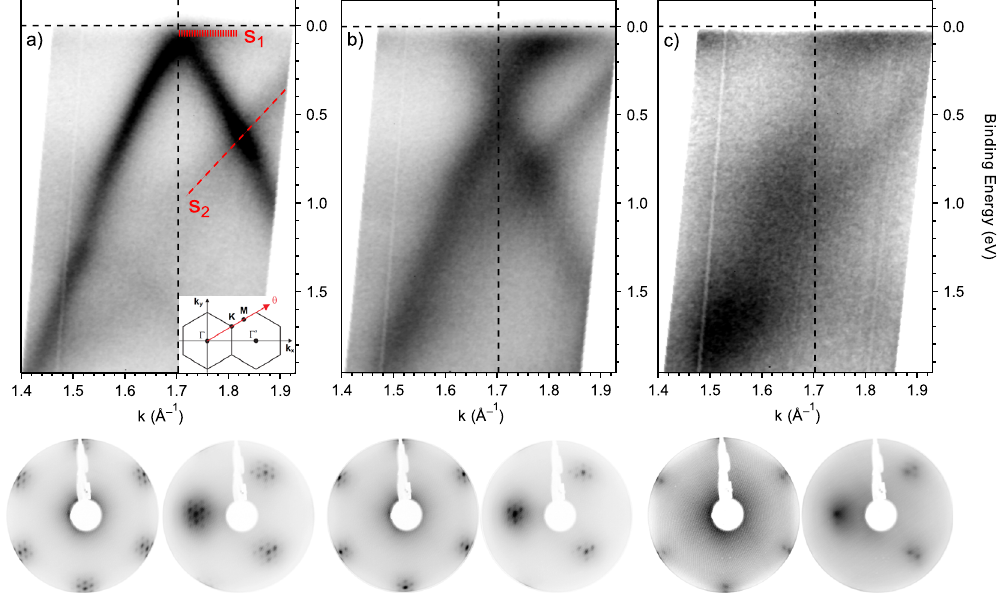
Figure 5. Top panels: band dispersion at the K point of the Brillouin zone obtained by plotting the ARPES intensity as a function of wave vector and binding energy for ( a ) pristine graphene/Ir(111), ( b ) after nitrogen doping and annealing at 600 °C and ( c ) after oxygen exposure. The red dashed lines indicate the two Ir surface states, S 1 and S 2 . Inset: experimental geometry of the ARPES experiment. Bottom panels: the corresponding LEED patterns respectively recorded with an electron energy of 78 eV with the (0,0) spot at the centre of the image and at an off-angle of